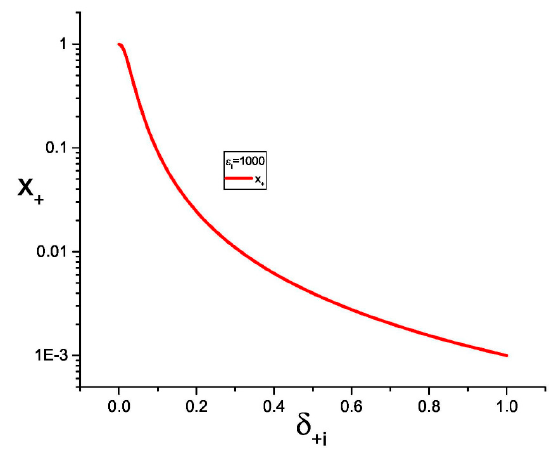
Figure 6. Positron energy as function of parameter δ + i for initial electron energy ε i =